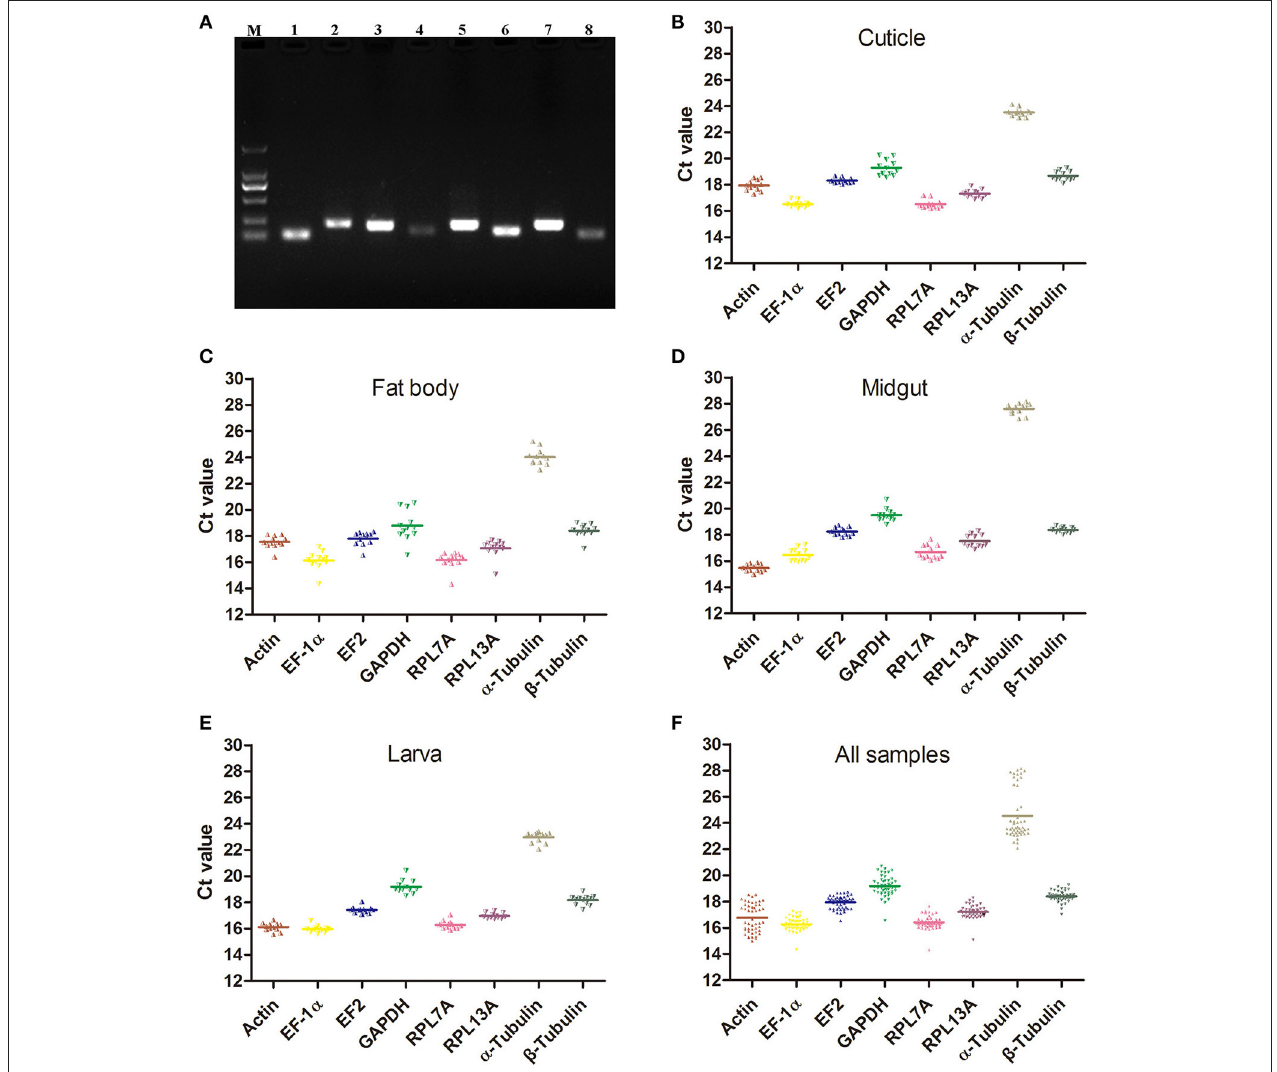
FIGURE 1 | The expression profiles of the eight candidate reference genes. (A) Agarose gel of eight candidate reference genes PCR products amplified with the RT-qPCR primers. Lanes: M, Marker 2000, lane 1-8, Actin, EF-1 α , EF2, GAPDH, RPL7A, RPL13A, α -Tubulin and β -Tubulin. (B–F) The expression profiles of the eight candidate reference genes in cuticle, fat body, midgut, larva, and all samples. (Actin), actin; (EF-1 α ), elongation factor 1alpha; (EF2), elongation factor 2; (GAPDH), glyceraldehyde 3-phosphate dehydrogenase; (RPL7A), ribosomal protein L7A; (RPL13A), ribosomal protein L13A; ( α -Tubulin), alpha-tubulin; ( β -Tubulin),